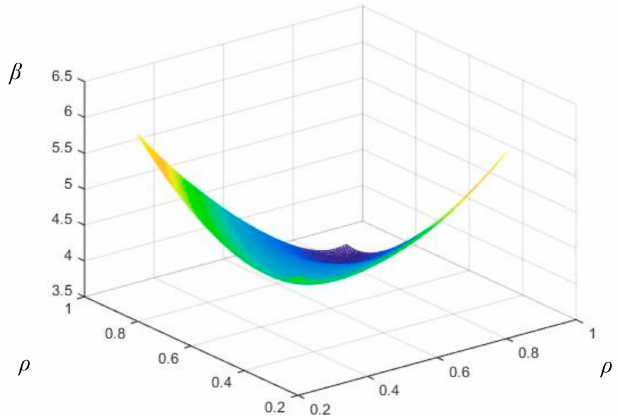
Figure 15. Non-probabilistic time-dependent reliability considering three interaction parameters of corroded defect.